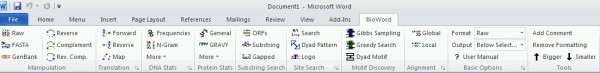
The BioWord ribbon. Functionally related tasks are grouped in separate tabs. Additional buttons and tab-specific options can be accessed through the boxed arrow icon located at the bottom right of tabs.